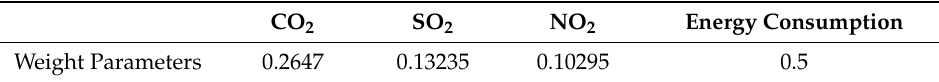
Table 11. Weight of each parameter in environmental